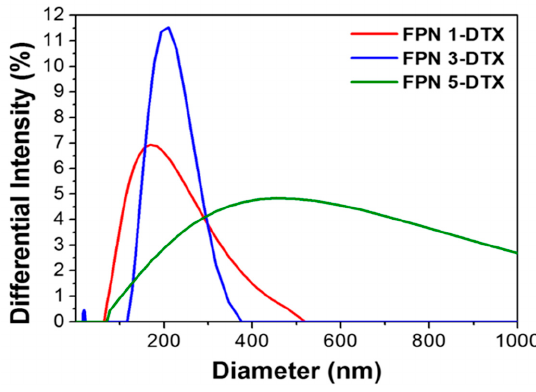
Figure 3. Size distributions of FPN 1-DTX, FPN 3-DTX, and FPN 5-DTX.